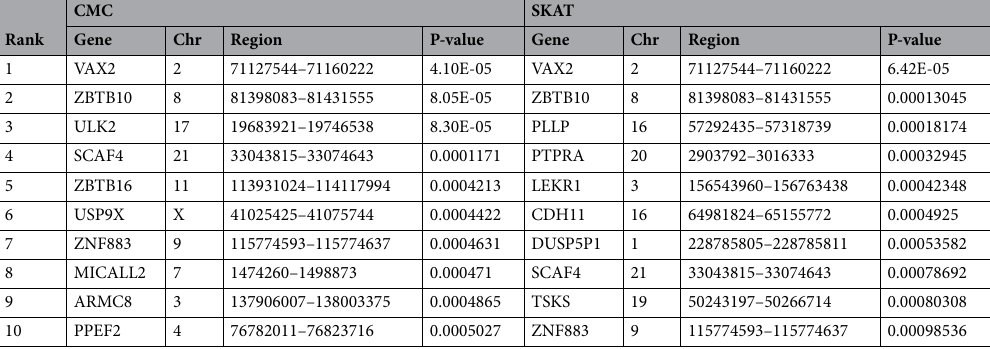
Table 3. Top 10 genes from gene-based analysis (CMC and SKAT) of low frequency and rare variants (MAF < 0.05).